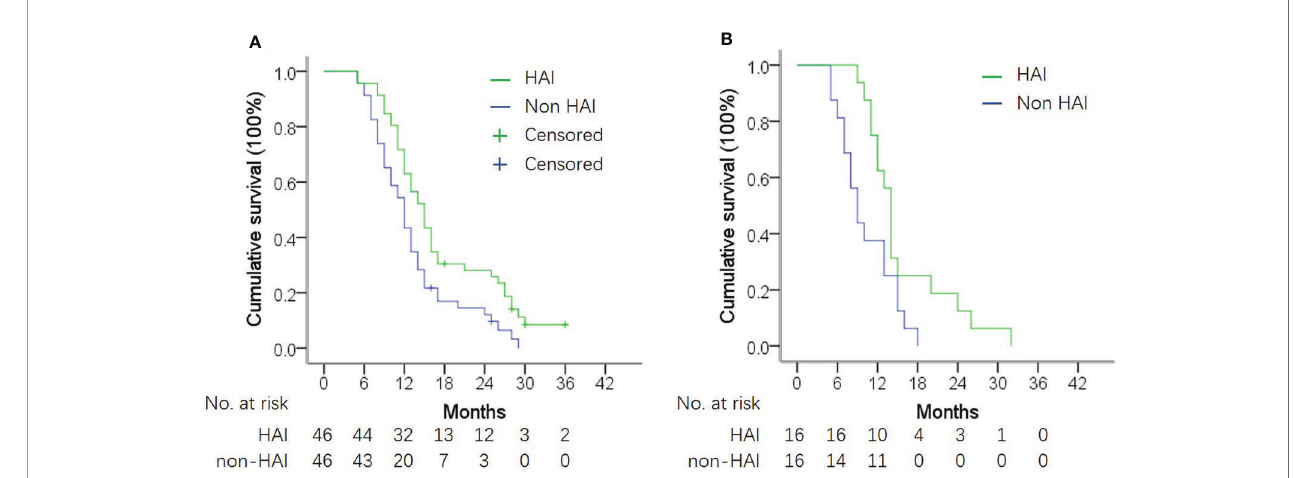
FIGURE 4 | OS in subgroup analysis according to presence of extrahepatic metastasis (EHM). (A) OS in patients without EHM. Median OS was 14.3 vs. 11.5 months in patients with and without HAI (log-rank test, P = 0.006). (B) OS in patients with EHM. Median OS was 10.8 vs. 13.5 months in patients with and without HAI (log-rank test, P =